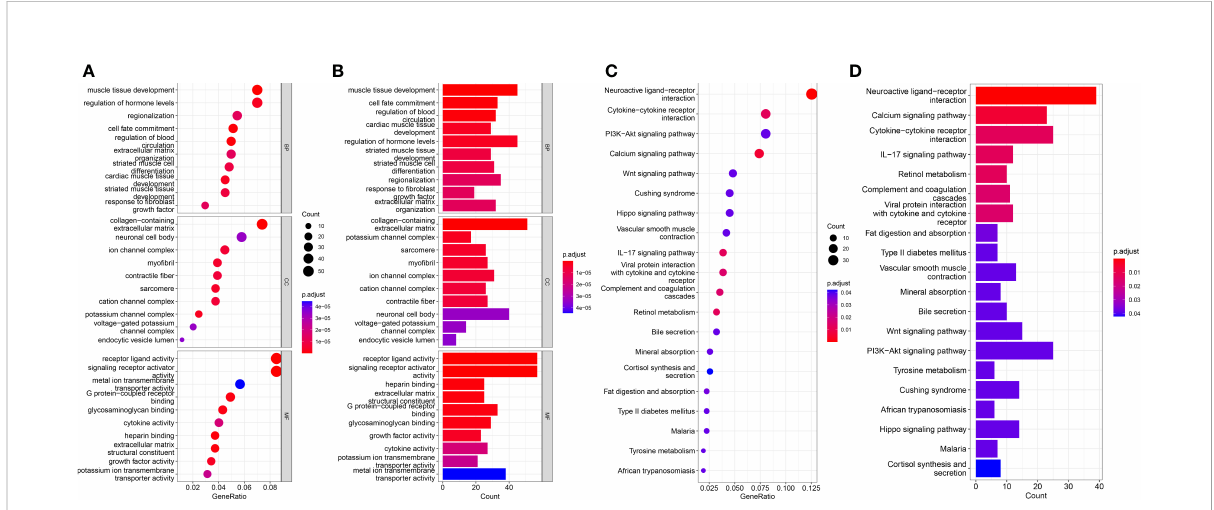
FIGURE 6 Results of GO and KEGG analyses in the TCGA cohort. (A, B) Signi fi cant GO enrichment in the TCGA cohort. (C, D) Signi fi cant KEGG pathways in the TCGA cohort.